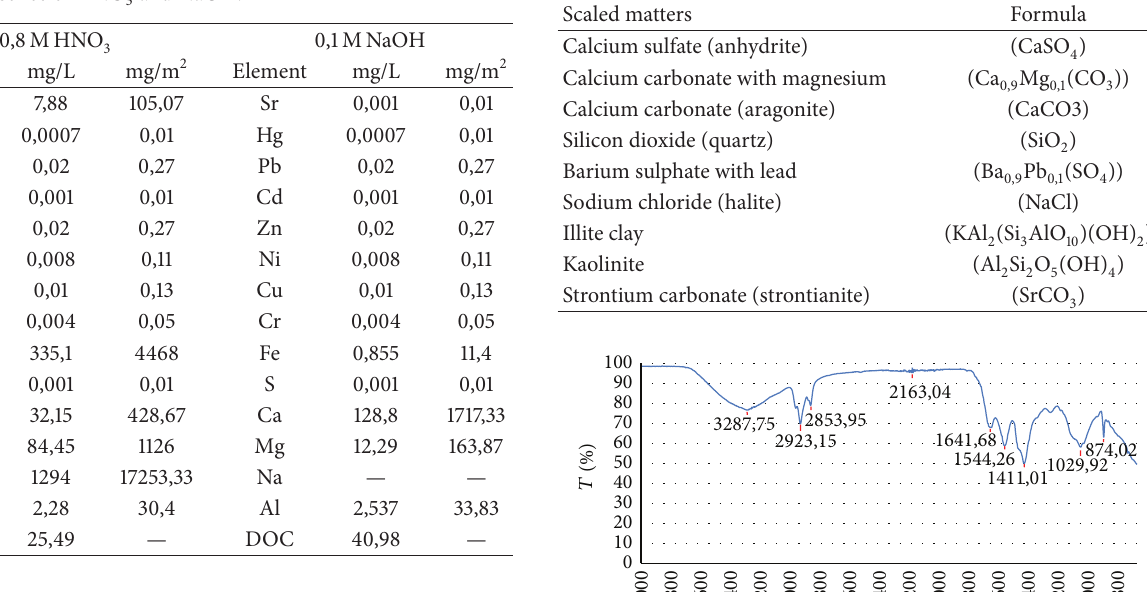
Table 1: ICP-OES and DOC results of extracted surface deposition and NaOH. in the presence of HNO 3